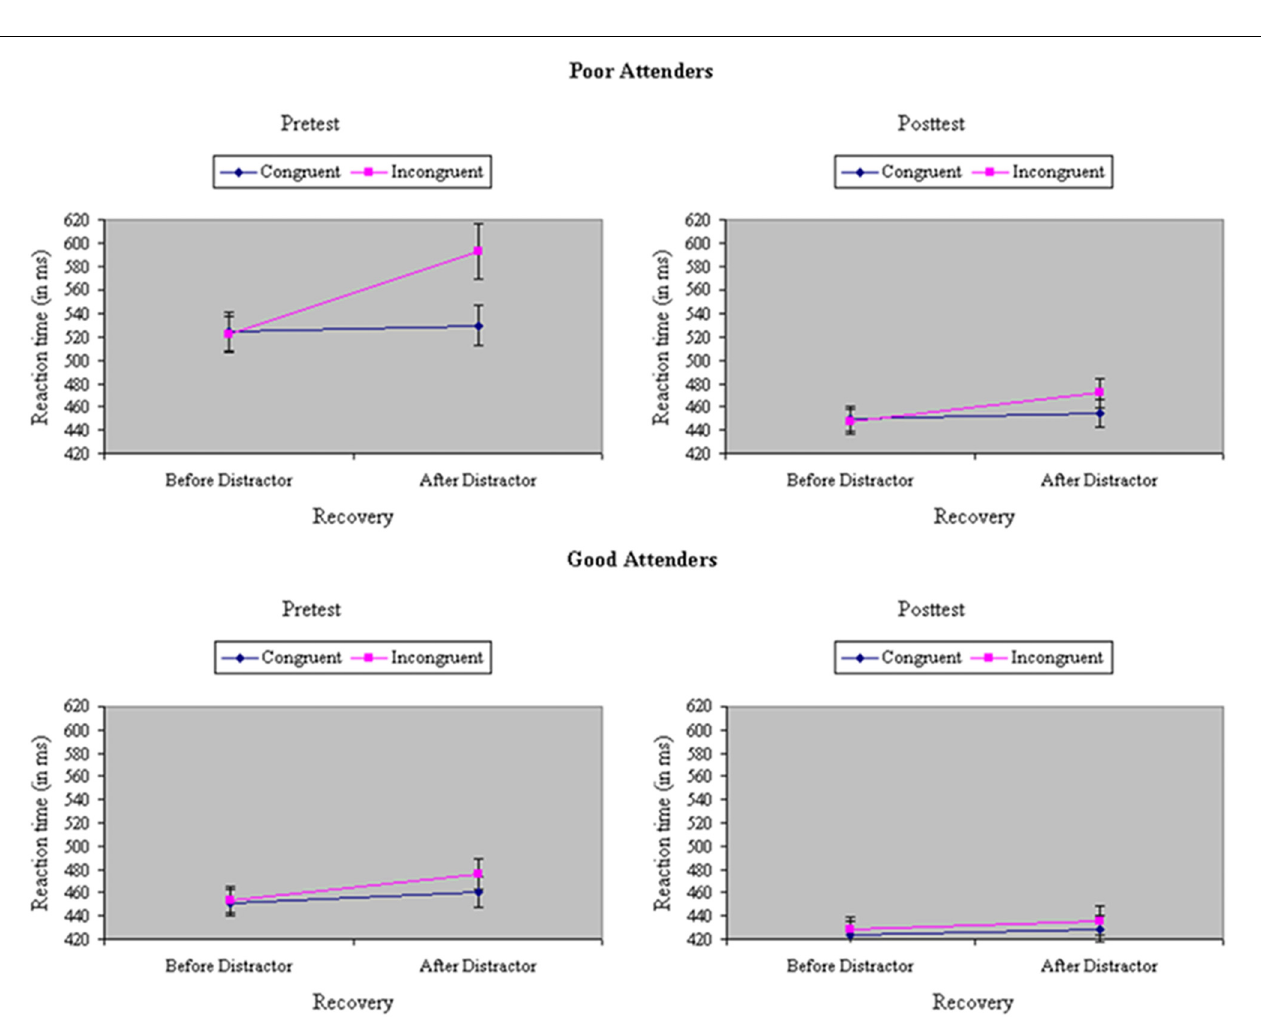
FIGURE 6 | Reaction time (in ms) on neutral trials in the filtering task, before versus after a trial with a congruent or incongruent flanker (distraction recovery), at pretest and posttest, separately by poor attenders (Top) and good attenders (Bottom). The effect of training on recovery was especially prominent in RTs after incongruent trials, an outcome restricted to participants showing relatively poor selective attention at pretest, yielding a significant Skill × Recovery × Test × Congruity interaction.